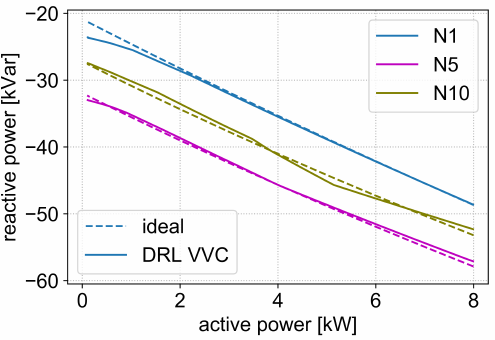
Figure 6. Reactive power output from the deep reinforcement learning (DRL) volt-var control (VVC) at the nodes N1, N5, and N10 after 80,000 training steps together with the calculated reactive power demand as a reference.